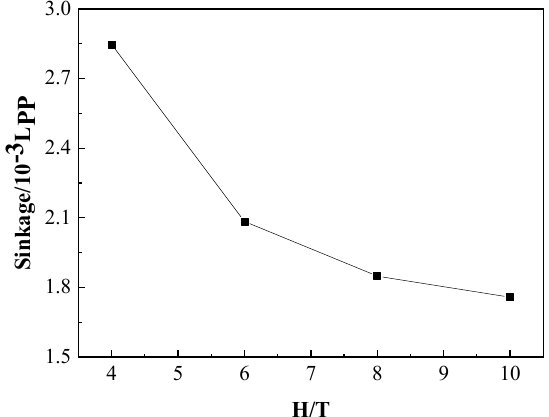
Figure 11. The dimensionless sinkage of the KCS scaled model with different depth/draft ratios (H/T).